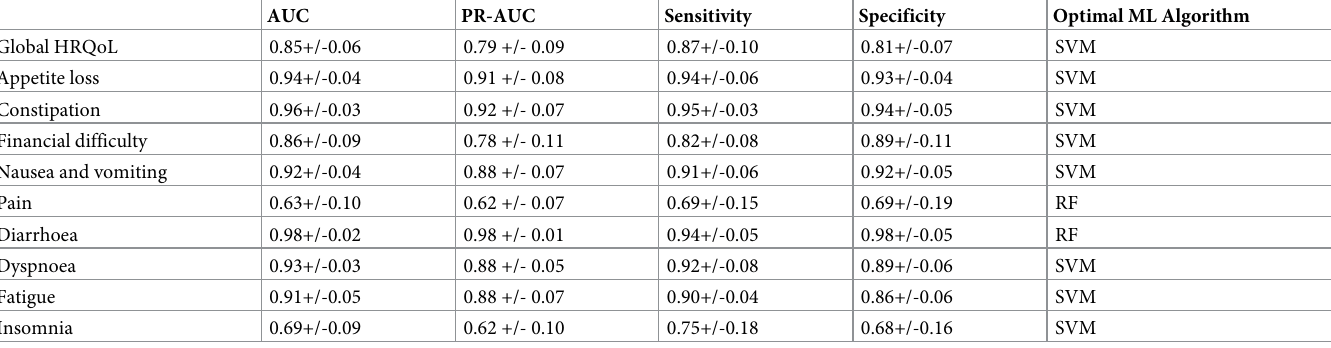
Table 3. Optimal model performance and algorithm type for each of the ten outcome variables.